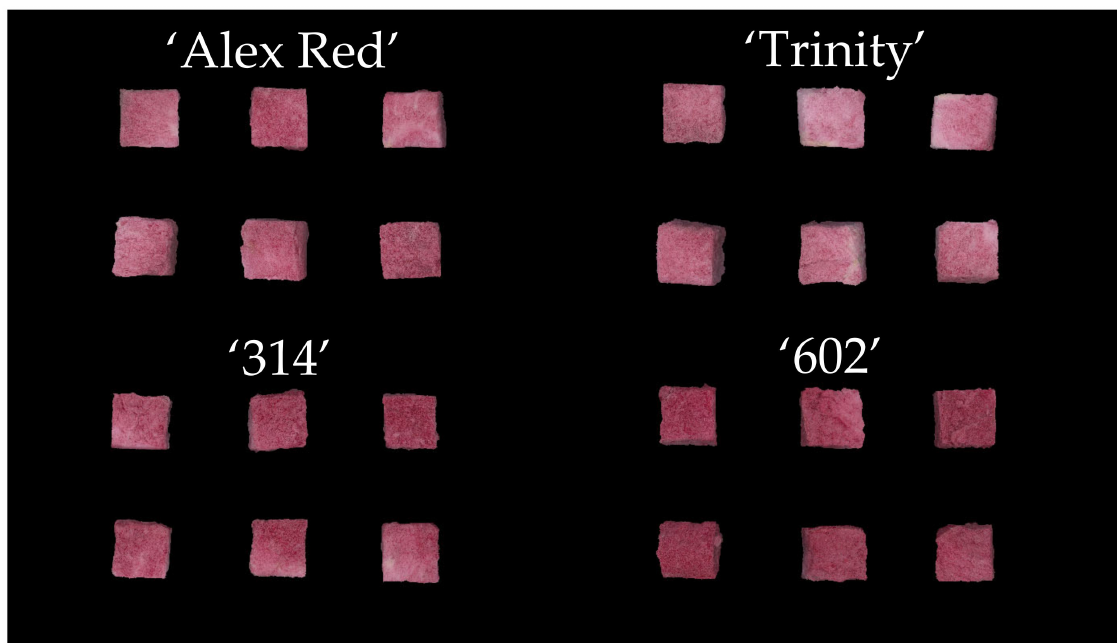
Figure 2. The sample color images of freeze-dried cubes of ‘Alex Red’, ‘Trinity’, ‘314’, and ‘602’ red-fleshed apple